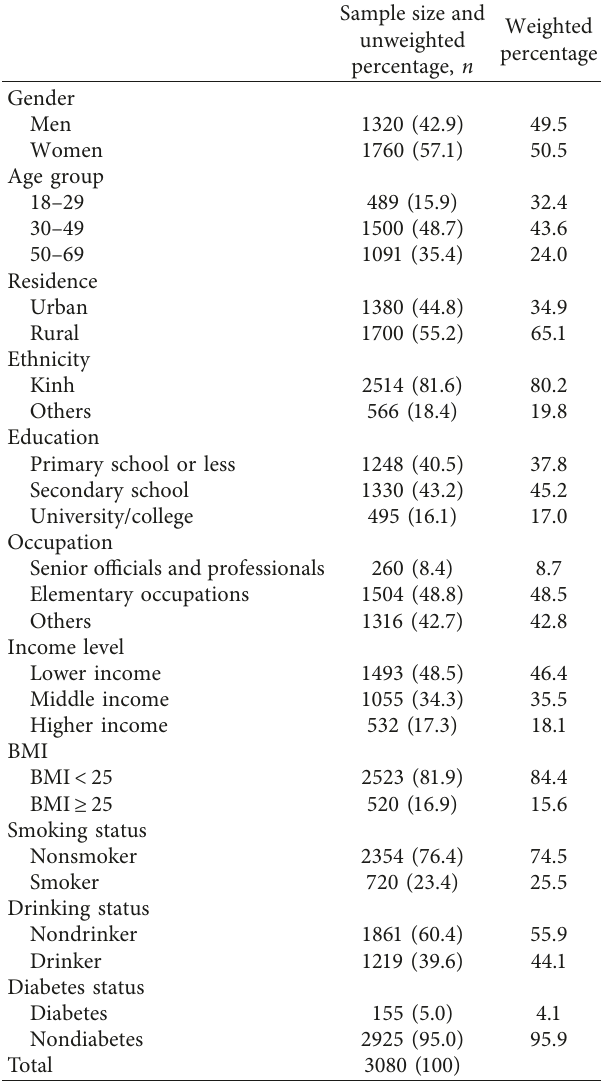
Table 3: General characteristics of the study respondents, STEPS Vietnam